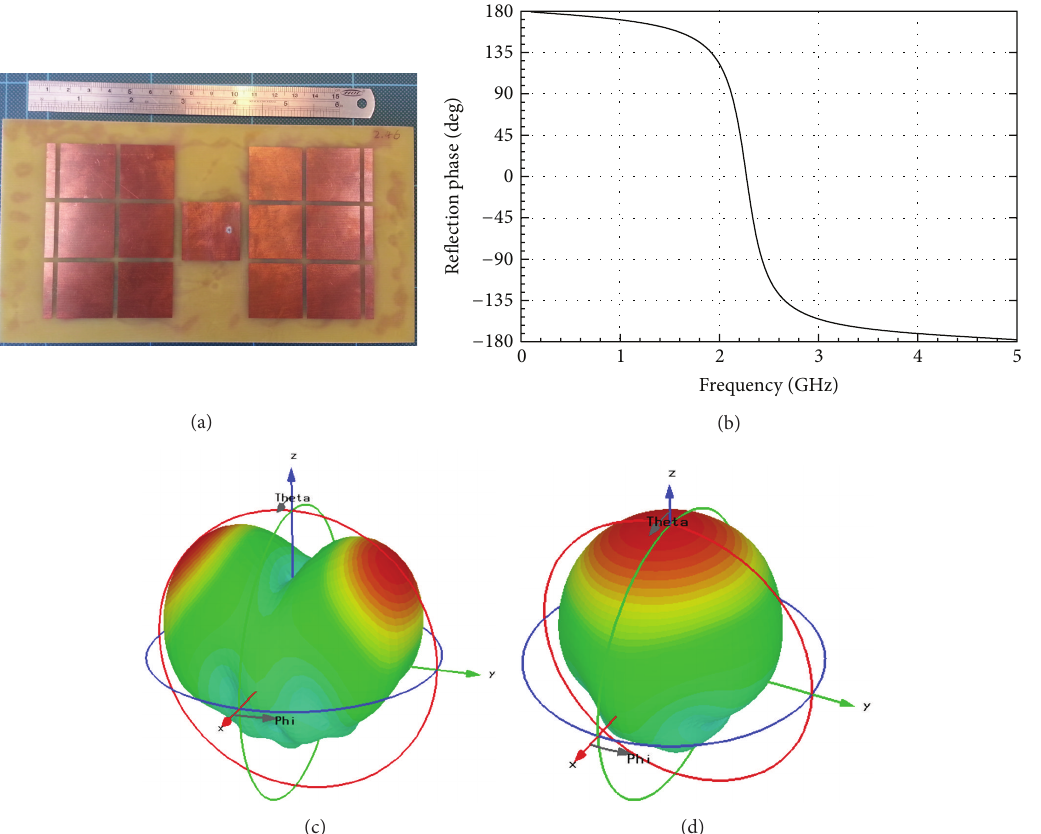
Figure 2: (a) Photograph of the fabricated model (without PIN diodes), (b) EBG reflection phase, (c) simulated radiation patterns for antenna with EBG, (d) simulated radiation patterns for antenna without